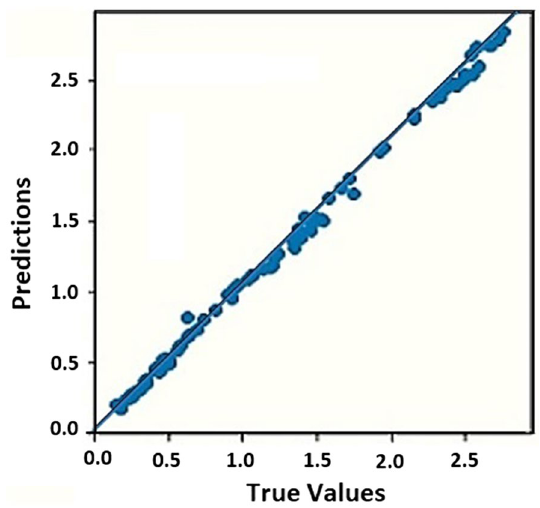
Figure 7. Testing the trained MLP neural network model with 30% of the 300 data of K value.